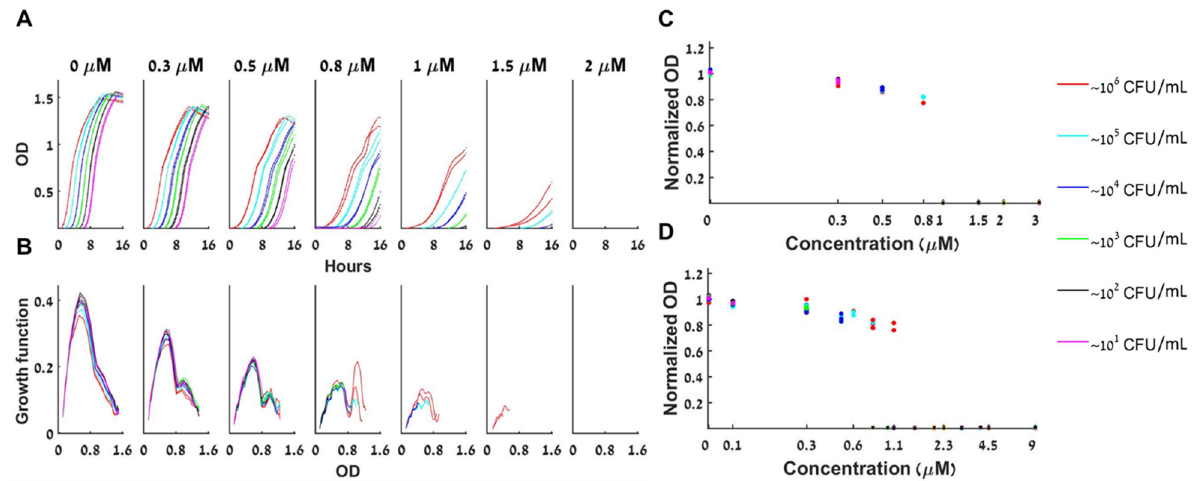
Figure 4. Dynamics of bacterial growth with Tetracycline. ( A ) The bacterial population is either extinct or growing with a similar growth curve under a given concentration of tetracycline. At any given antibiotic concentration A (one of the seven subplots), all loads that grow have similar growth curves, shifted in time (different colors correspond to different initial loads as indicated, duplicates are shown). For A > 1 μ m some of the small loads fail to grow altogether. The maximal growth capacity declines as the antibiotic concentration A rises. ( B ) The specific growth function ( dOD/dt versus OD) of the different loads changes as a function of A but remains fairly constant for all loads at a given A . ( C ) The maximal capacity of all loads at a given tetracycline concentration A is always similar and declines as A becomes bigger. Normalized maximal capacities of one representative experiment are presented. ( D ) The normalized maximal capacity for six experiments together exhibits bistability and the same decline with the concentration A.